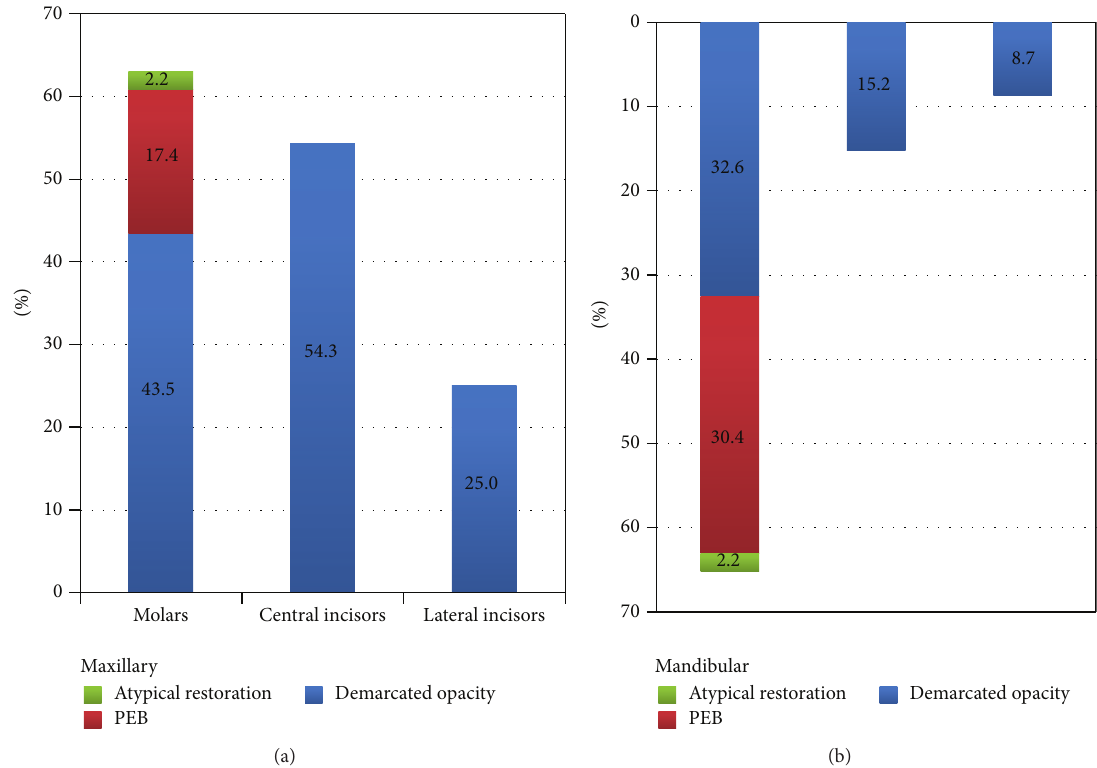
Figure 2: Prevalence of MIH in maxillary and mandibular permanent index teeth. The prevalence of MIH was higher in maxillary compared to mandibular central incisors ( 𝑃 = 0.01 ).